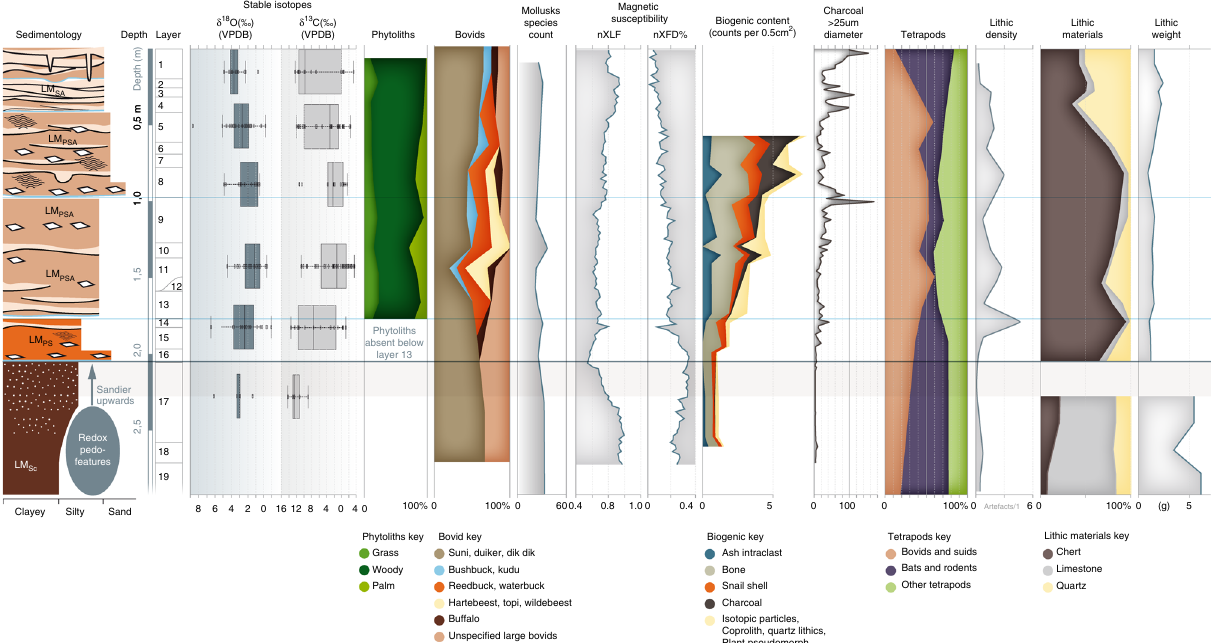
Fig. 3 The palaeoenvironmental and human occupation proxies from PYS. From left to right: Sedimentology (LM(SC) sandy clayey loam, LM(PS) pebbly sandy loam, LM(PSA) pebbly sandy ashy loam, LM(SA) sandy ashy loam); Depth; Layer divisions; Box and whisker plots of stable oxygen and carbon isotope values of mammalian teeth; Phytoliths, showing the proportion of grass, palm, and woody taxa; Percentage of different bovids in Minimum Number of Individuals (MNI); Terrestrial mollusk rare fi ed species count; Magnetic susceptibility (XLF and XFD%); Biogenic content of micromorphology thin sections; Microcharcoal abundance; Proportions of selected faunal groups as a percentage of total tetrapod MNI; Lithic density; Lithic material types; Lithic weight (mean debitage